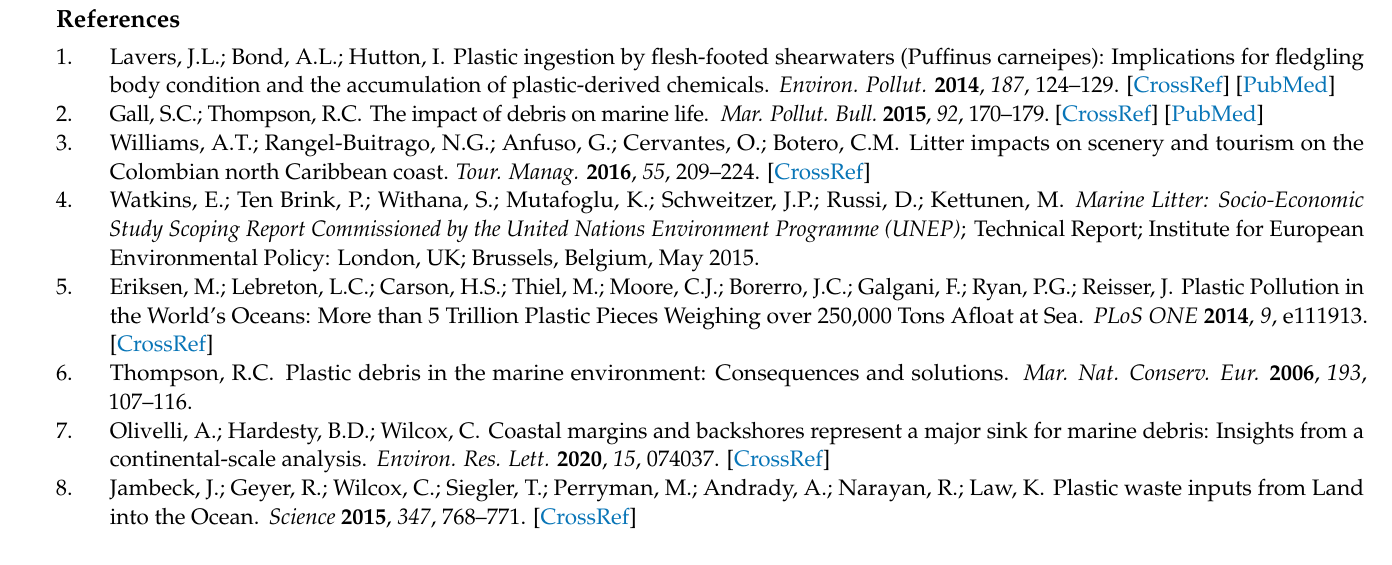
Figure A1. Average spectral reflectance measurements from each of the MPD containing quadrats from the two field sites, grouped by surface